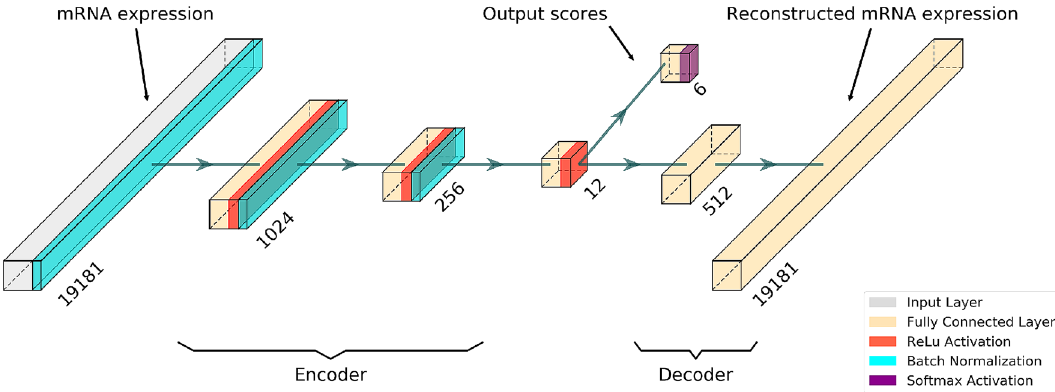
Figure 2. The network architecture: an autoencoder is utilized to extract a meaningful low-dimensional latent representation from a molecular profile. Meanwhile, the 12-dimensional latent representation has the ability to correctly classify the three tissues and disease states of a gene expression profile. Numbers aligning along each layer represent the number of